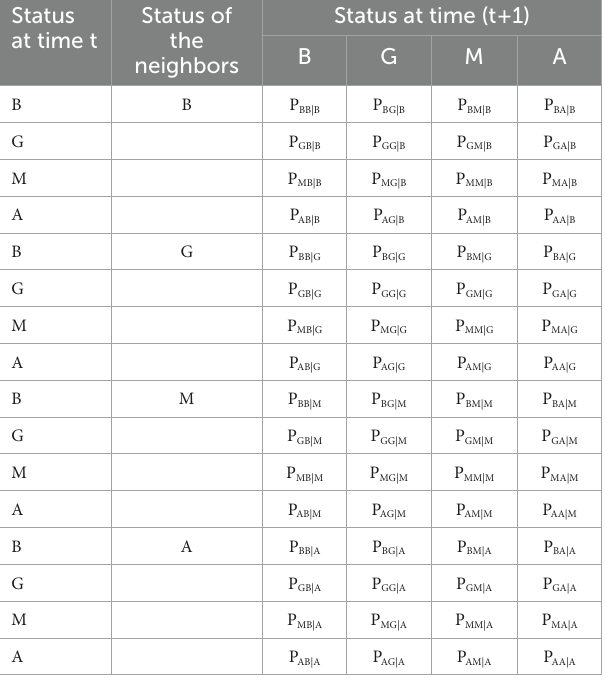
TABLE 4 A spatial Markov matrix. Status at time